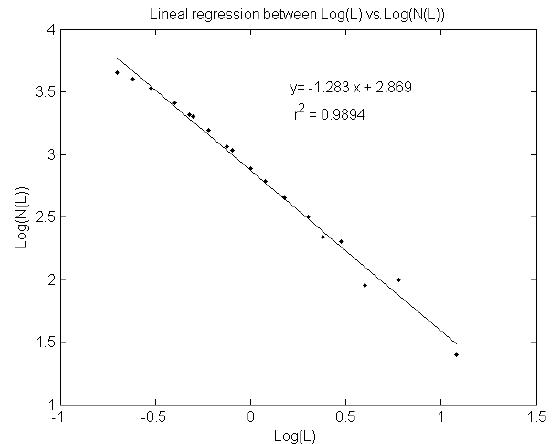
Figure 1. Example of linear regression between the number of non- empty boxes and the length side of the box. The slope ( d) is the fractal dimension of the w (cid:48) component, d = 1 . 28 ± 0 . 03, for an ex- ample of the w (cid:48) component of the wind